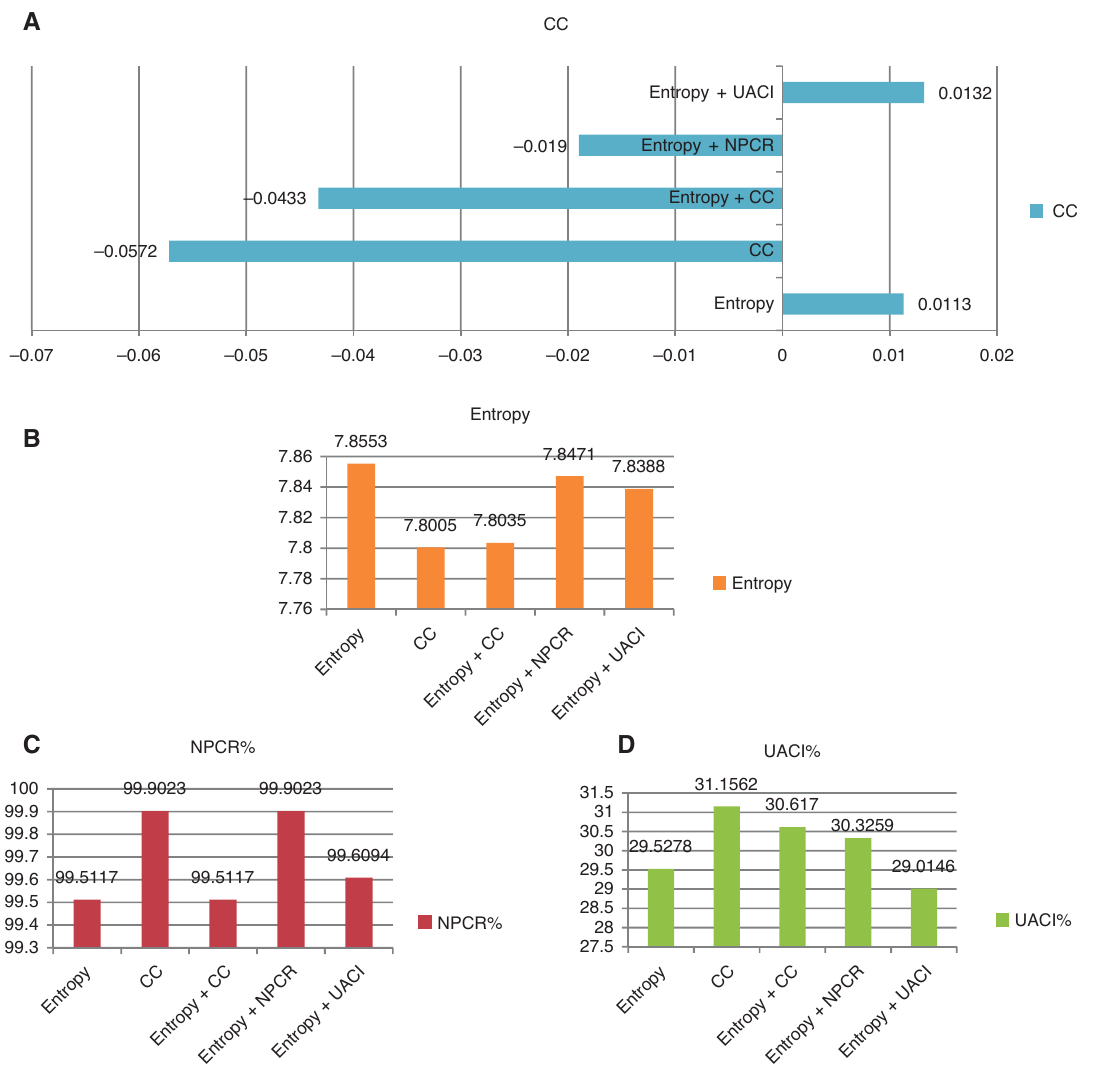
Figure 7: Comparative Analysis for Rice Image Using Transformed Logistic Map Function. (A) CC for rice image; (B) entropy for rice image; (C) NPCR for rice image; (D) UACI for rice